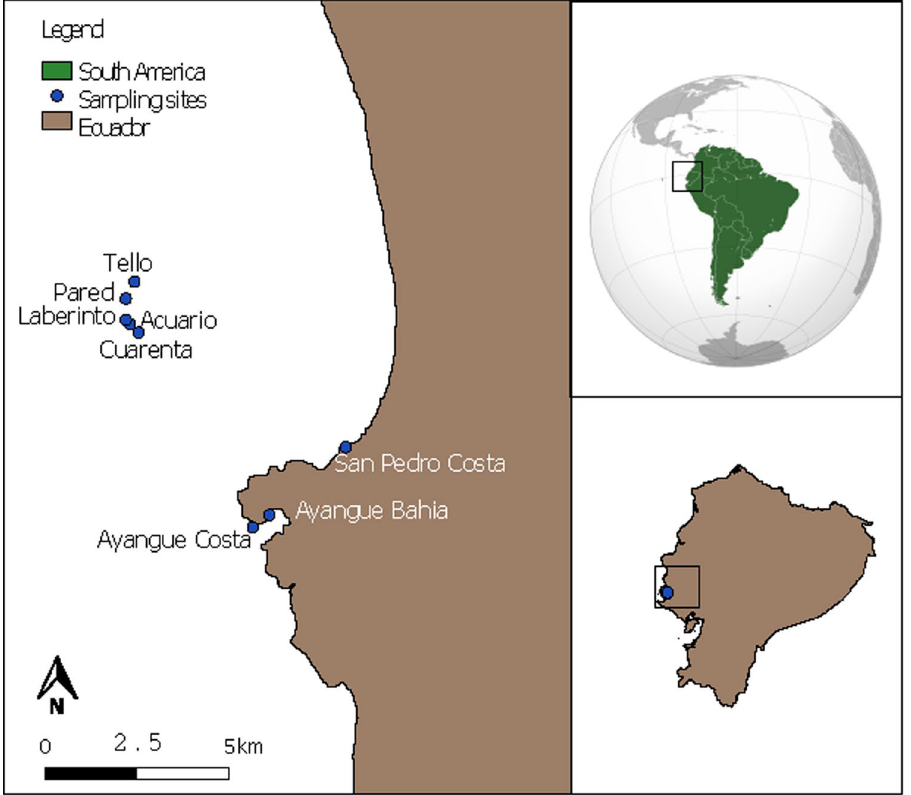
Figure 5. Map of the Marine Protected Area El Pelado with eight sampling locations of the zoantharians (This map was created using QGIS ® software under the terms of the GNU Free Documentation License Version